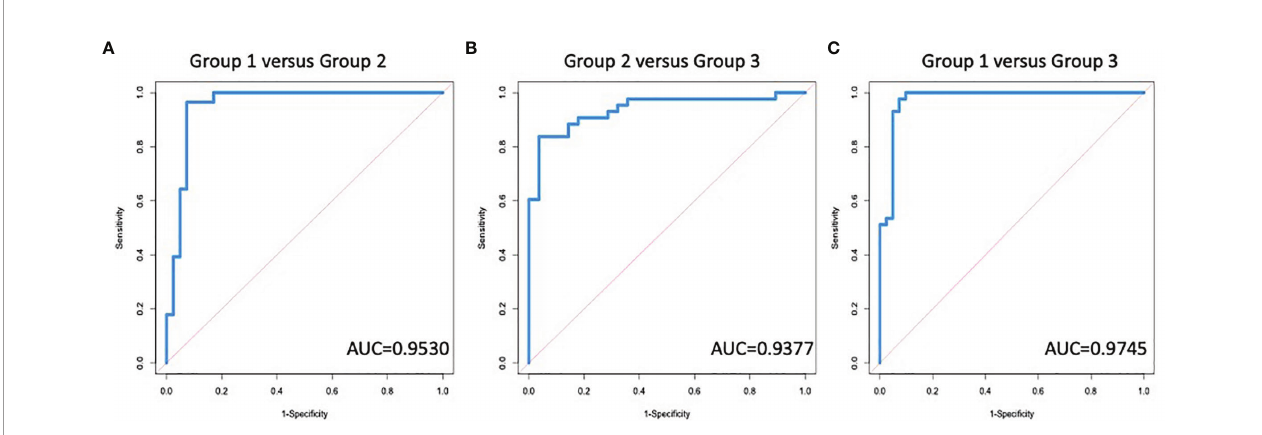
FIGURE 4 | A Diagnostic algorithm based upon IgG glycans can identify the degree of fi brosis in patients with liver disease. AUROC for the differentiation of (A) group 1 (no fi brosis) versus group 2 (early to moderate fi brosis); (B) group 2 versus group 3 (signi fi cant fi brosis or cirrhosis); or (C) group 1 versus